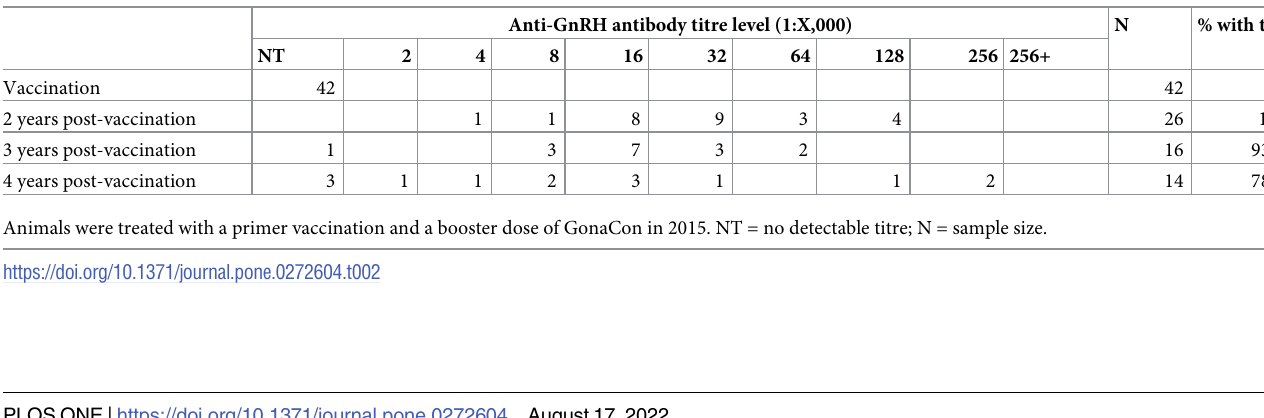
Table 2. Number of treated cattle in Cohort 1 and relative anti-GnRH antibody titres at each time point following initial vaccination. Anti-GnRH antibody titre level (1:X,000) Vaccination